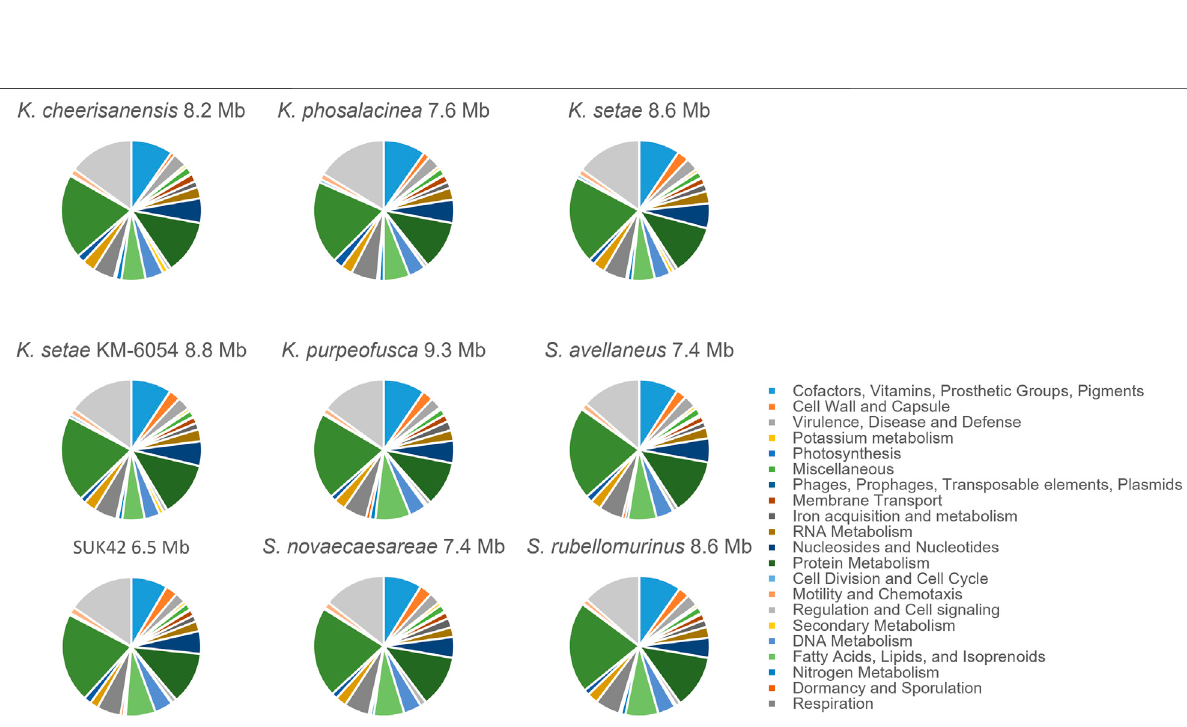
Frontiers in Bioengineering and Biotechnology |